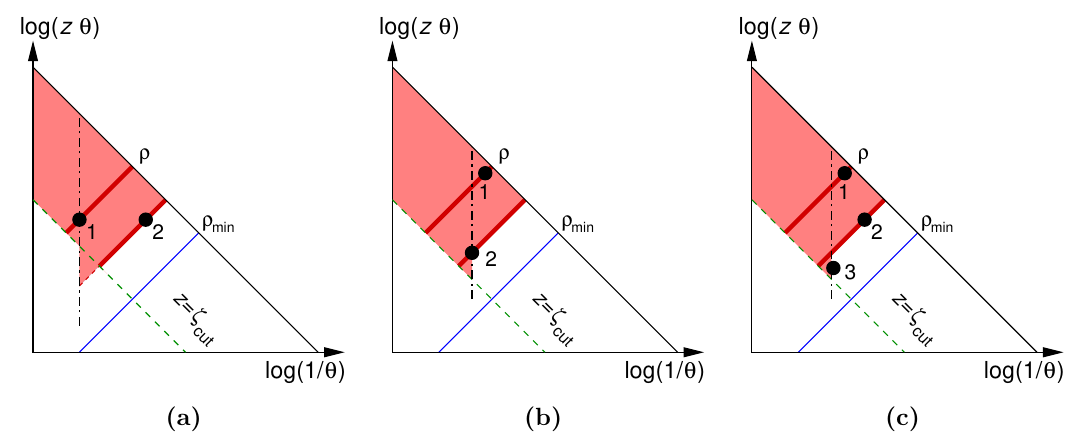
Figure 2. Lund plane corresponding to Y m -splitter with grooming. Emissions 1 and 2 have respectively the largest and second-largest gen- k t distance (or mass). The 3 plots (a), (b) and (c) correspond to three di(cid:11)erent possibilities where the emissions 1, 2 and 3 respectively are the largest-angle emissions that pass the mMDT